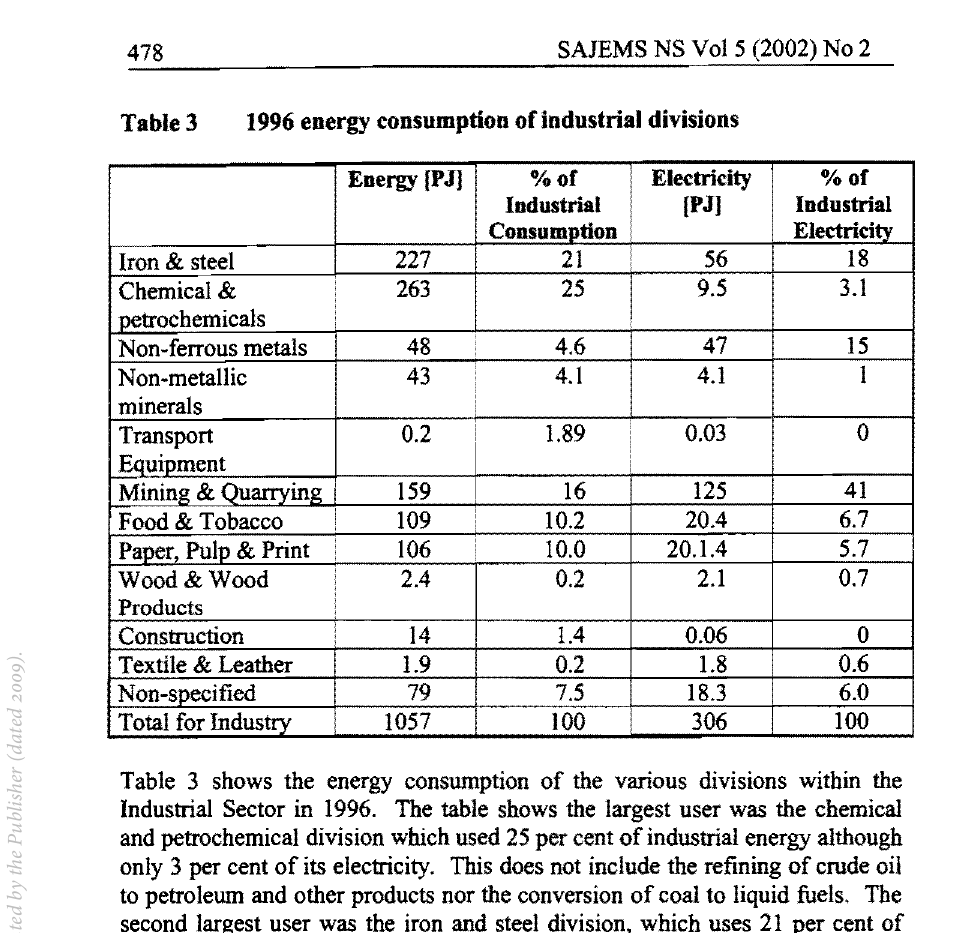
1996 energy consumption oCindustrial